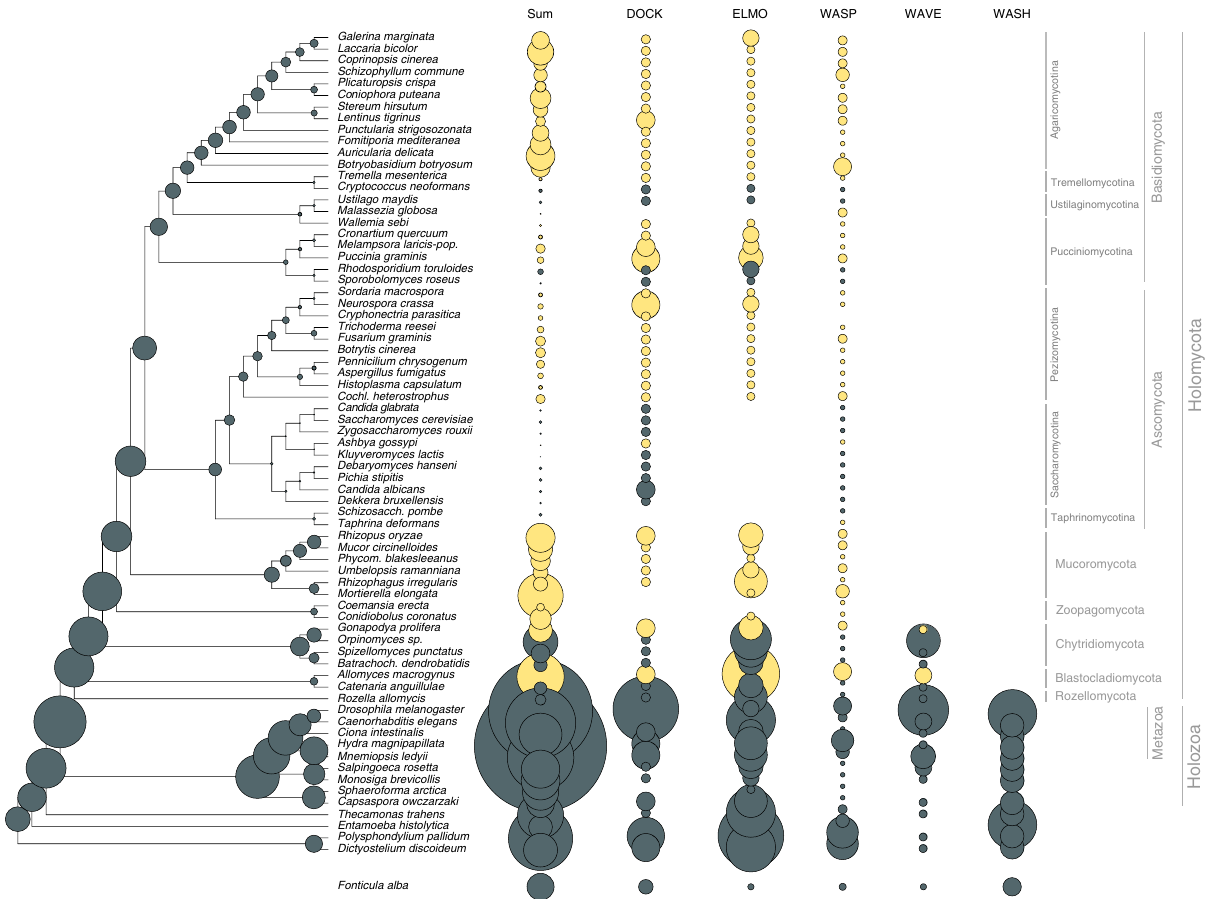
Fig. 4 Evolutionary history of phagocytosis-related gene families. Several phagocytotic gene families retained in fi lamentous fungi (DOCK, ELMO, WASP). WAVE family retained only in early fungi (Blastocladiomycota and Chytridiomycota), WASH family is represented only in non-fungal eukaryotes. Bubble size is proportional to ancestral and extant gene copy number. Copy numbers of fi lamentous fungi are labeled with